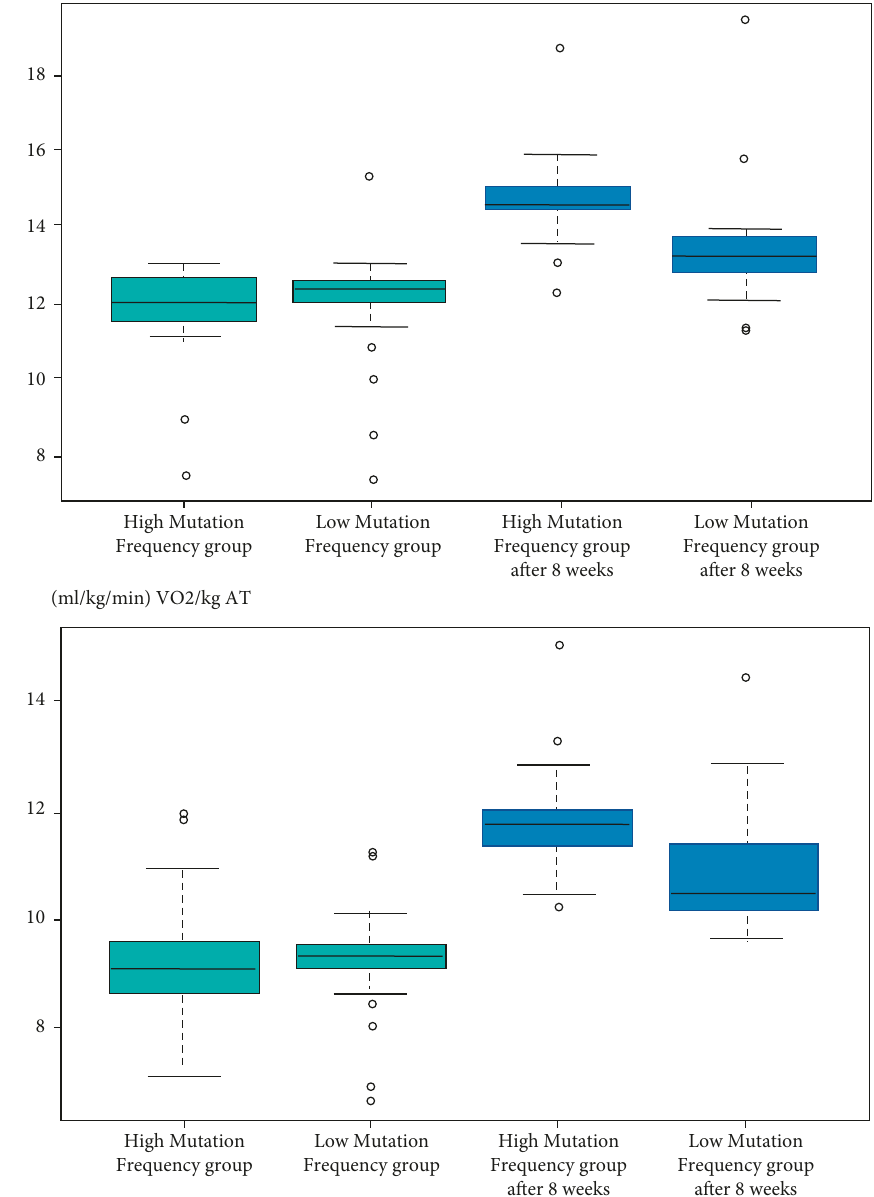
Figure 5: VO 2 /kg at peak and VO 2 /kg at AT before and after the 8-week exercise